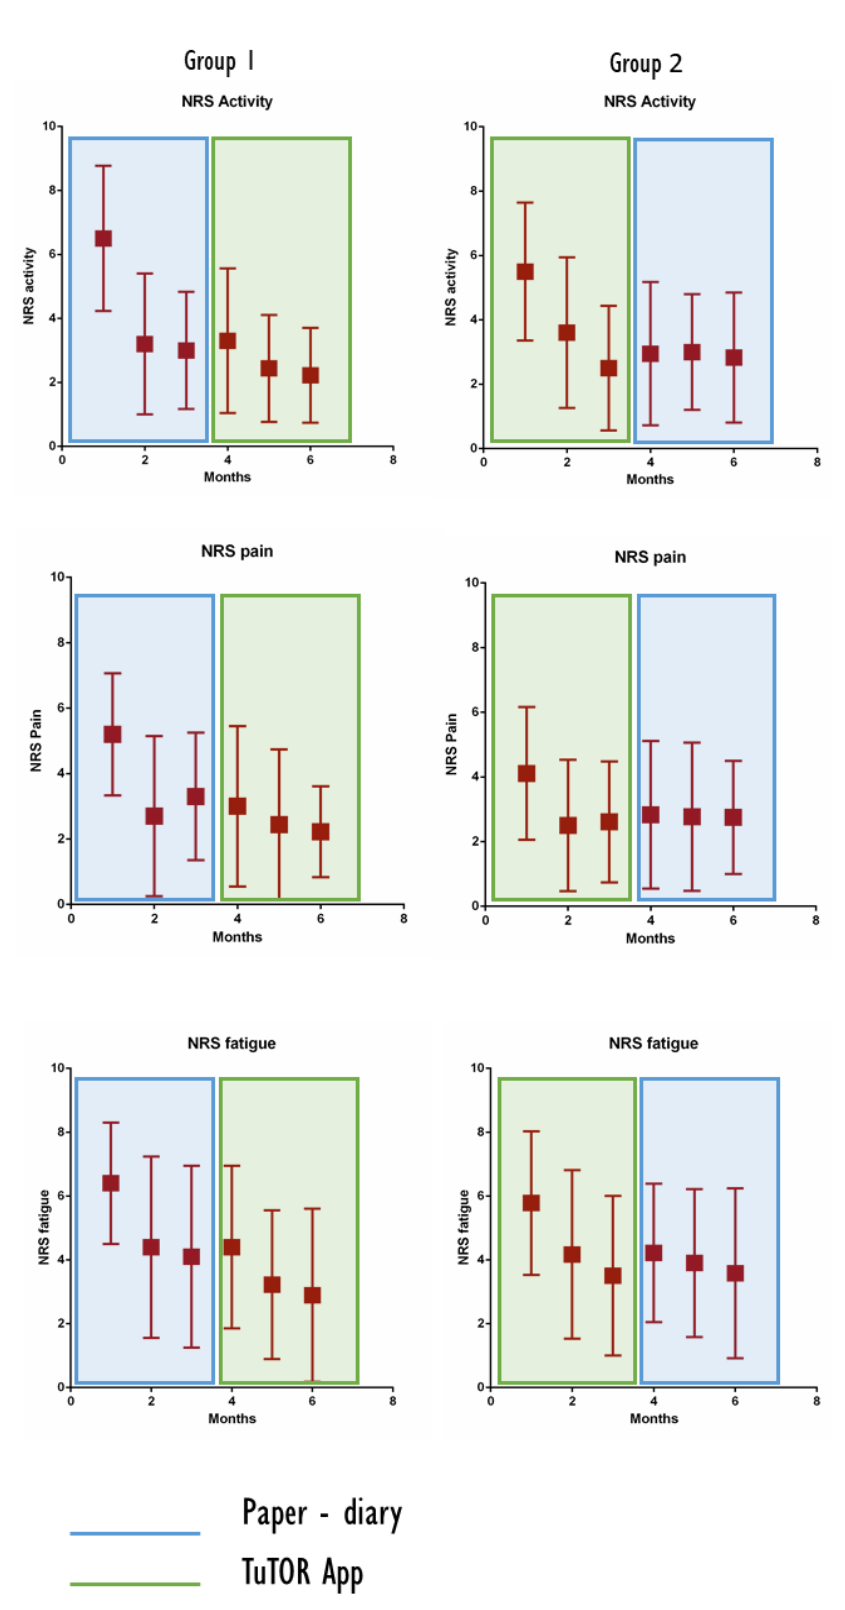
Figure 4. Decrease in NRS perceived activity, pain and fatigue in the PD and TuTOR app